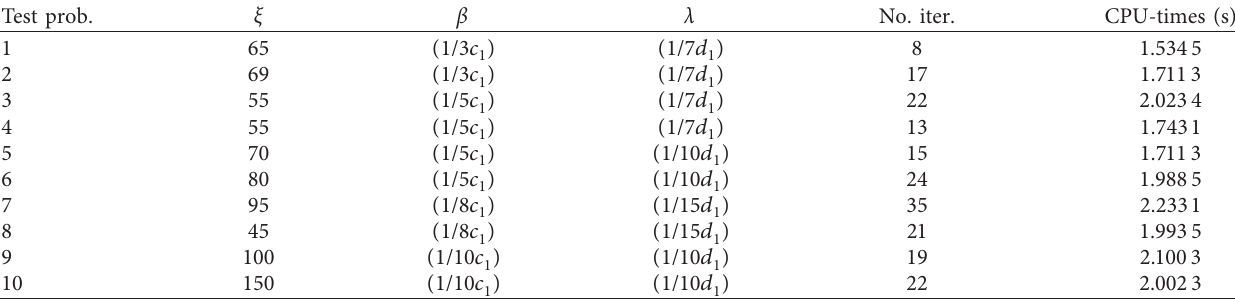
Table 1: Computed results for Algorithm 3.1 with the different parameters. Test prob.